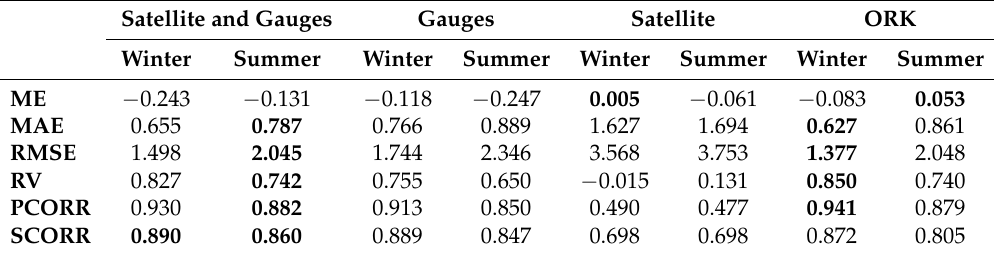
Table 12. Daily precipitation regression scores averaged on the climatological test gauges, for the test days and separating the year into two hydrological seasons. The summer season starts on the 1st of April and finishes on the 30th of September. The ME, the MAE and the RMSE are expressed in